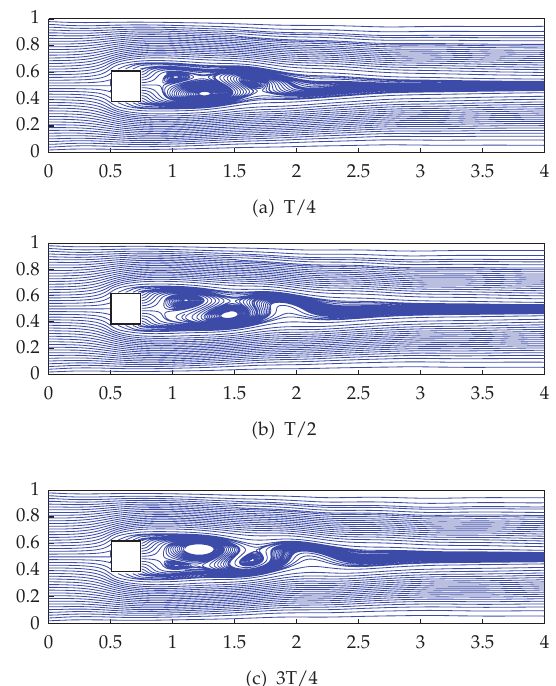
Figure 7: The streamline patterns for flow field from 48 × 160 element grid and Δ t (cid:9) 0 . 01s time step at Re (cid:9)